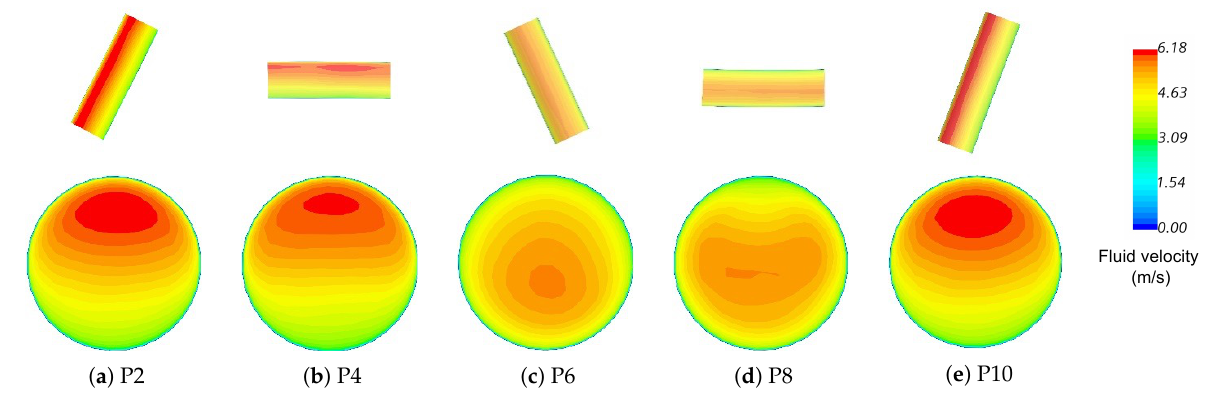
Figure 10. Local concentration and particle velocity in cross sections of the typical monitors. Black hollow square markers represent C vl and red hollow triangle markers represent V xl .